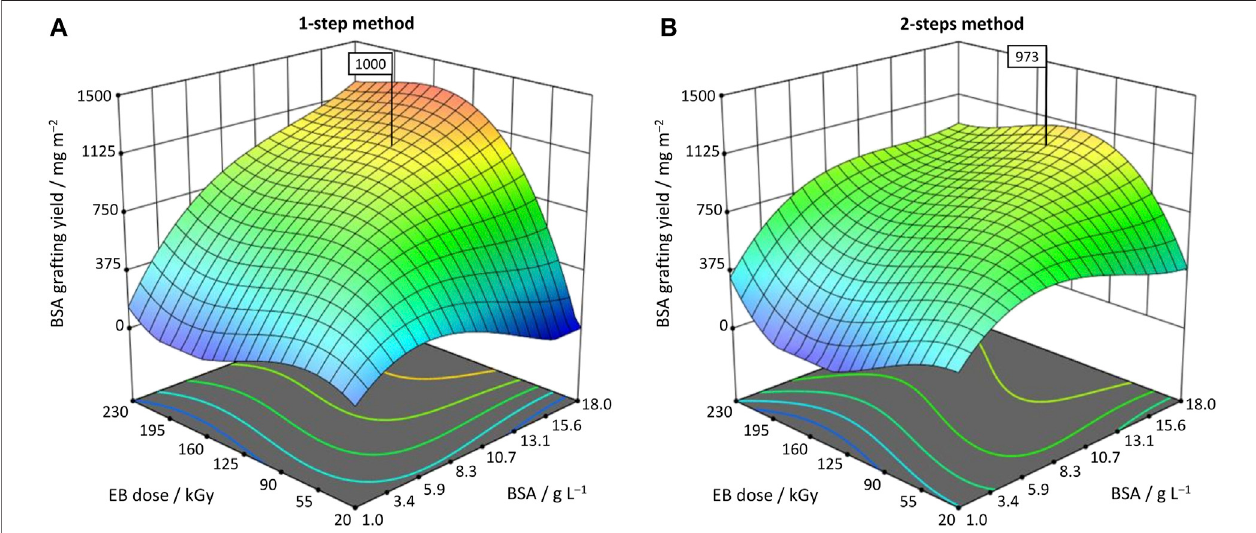
FIGURE 4 | 3D response surface plots for (A) optimized 1-step method (t (cid:1) 2.7 min); and (B) optimized 2-steps method (t (cid:1) 5.7 min). The fl ags highlight the predicted BSA grafting yield after numerical optimization via desirability function.